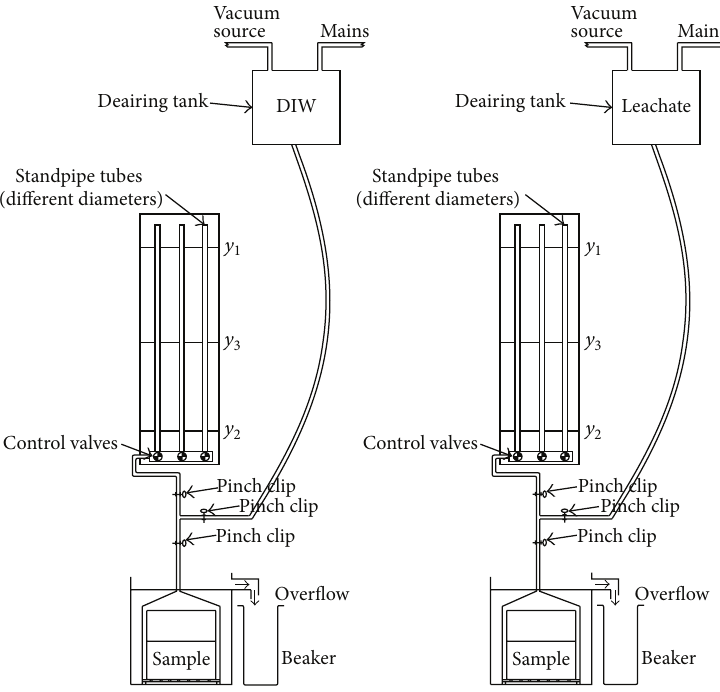
Figure 1: Experimental setup for determination of hydraulic conductivity.